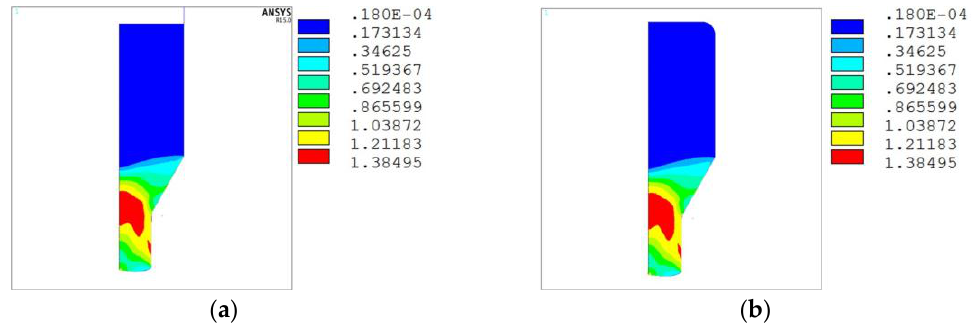
Figure 4. Von-Mises equivalent strain distribution of ( a ) displacement-load model and ( b ) pressure-load model.